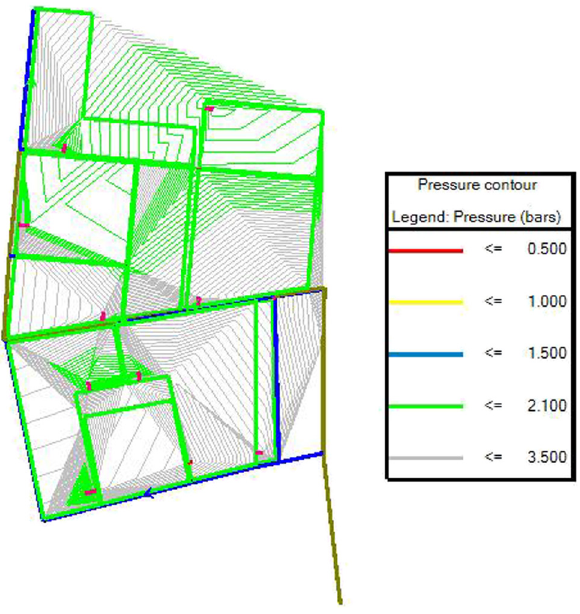
Figure 9: Contour map of the pressure heads during low water